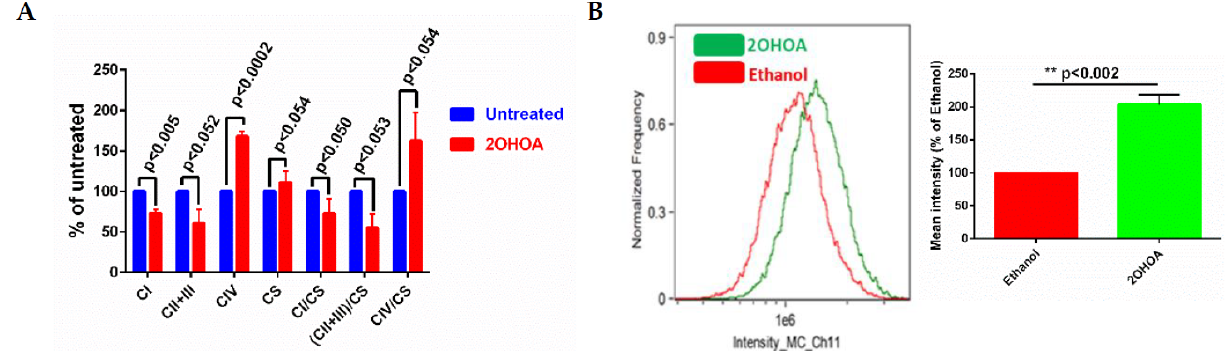
Figure 4. ( A ) Respiratory complex activities of control and 2OHOA (200 µ M, 48 h) treated U118MG cells. In addition to respiratory complexes, the activity of citrate synthase (CS) was also measured to report the biomass of intact mitochondria. Citrate synthase normalized values are also shown. All differences between 2OHOA and untreated mitochondria are statistically significant as determined by multiple t -tests ( n = 3, Holm–Sidak method, assuming no interdependence among comparisons and no consistent variance among the means). p values are indicated. ( B ) Left panel , U118MG cells were treated with 200 µ M 2OHOA for 48 h, or with an equal volume of 0.5% ethanol as a solvent-only control, as indicated. Cells were then fixed and stained by Mitotracker Deep Red to quantify mitochondrial mass. Right panel , quantification of the differences between 0.5% ethanol and 2OHOA, based on n = 3 experiments as shown in the Left panel . Shown are means ± SEM, n = 3. Statistical significance ( p value) was determined by Student’s t -test.